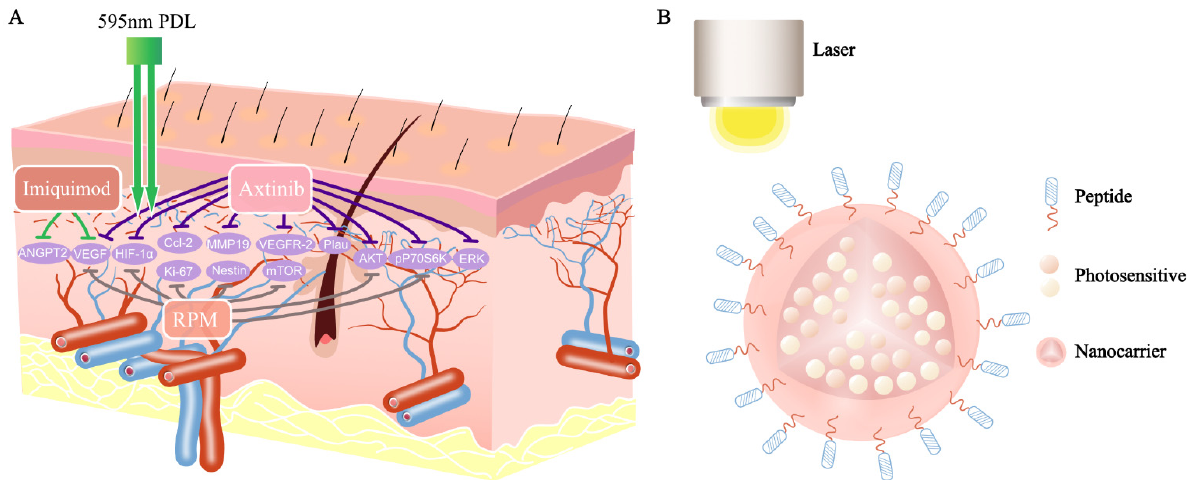
Figure 2. Antiangiogenic agents combined with PDL and a novel PDT for treatment of PWSs: ( A ) axitinib inhibits the mRNA levels of HIF-1 α , VEGF, Ccl2, Plau, and MMP19 increased by PDL. In addition to this, it also blocks PDL-induced pERK, pAKT, and pP70S6K. The expression of VEGF and ANGPT2 decreased in the PDL combined with the imiquimod sample, compared with PDL alone. RPM inhibits the PDL-induced expression of Ki-67, nestin, HIF-1 α , VEGF, P70S6K, etc.; ( B ) a novel PDT for treatment of PWSs: photosensitizers (ICG, IR-780, IR-783) are encapsulated inside nanocarriers, which are conjugated with special markers (CD133/CD166/EphB1/EfnB2/VEGFR-2). Beta-blockers (propranolol and timolol) are mainly utilized to treat infantile heman- giomas, which can prevent neovascularization by inhibiting VEGF, basic fibroblast growth factor (bFGF), MMP2, and MMP9 [89]. Hence, some scholars have tried to treat PWSs with PDL combined with topical beta-blockers to control the recurrence of PWSs. However, a multicenter randomized controlled trial revealed that the application of topi- cal timolol gel for preventing neoangiogenesis did not significantly improve the recur- rence of PWSs when treated with PDL [90]. GNAQ mutations are known to mildly activate the MAPK pathway, and they may stimulate the expression of endothelin, which could prevent neoangiogenesis. Thus, Taquin et al. used oral bosentan (2 mg/kg twice daily), an inhibitor of endothelin receptors, combined with PDL, to treat PDL-resistant PWSs in four patients [91]. Only one patient was markedly improved.